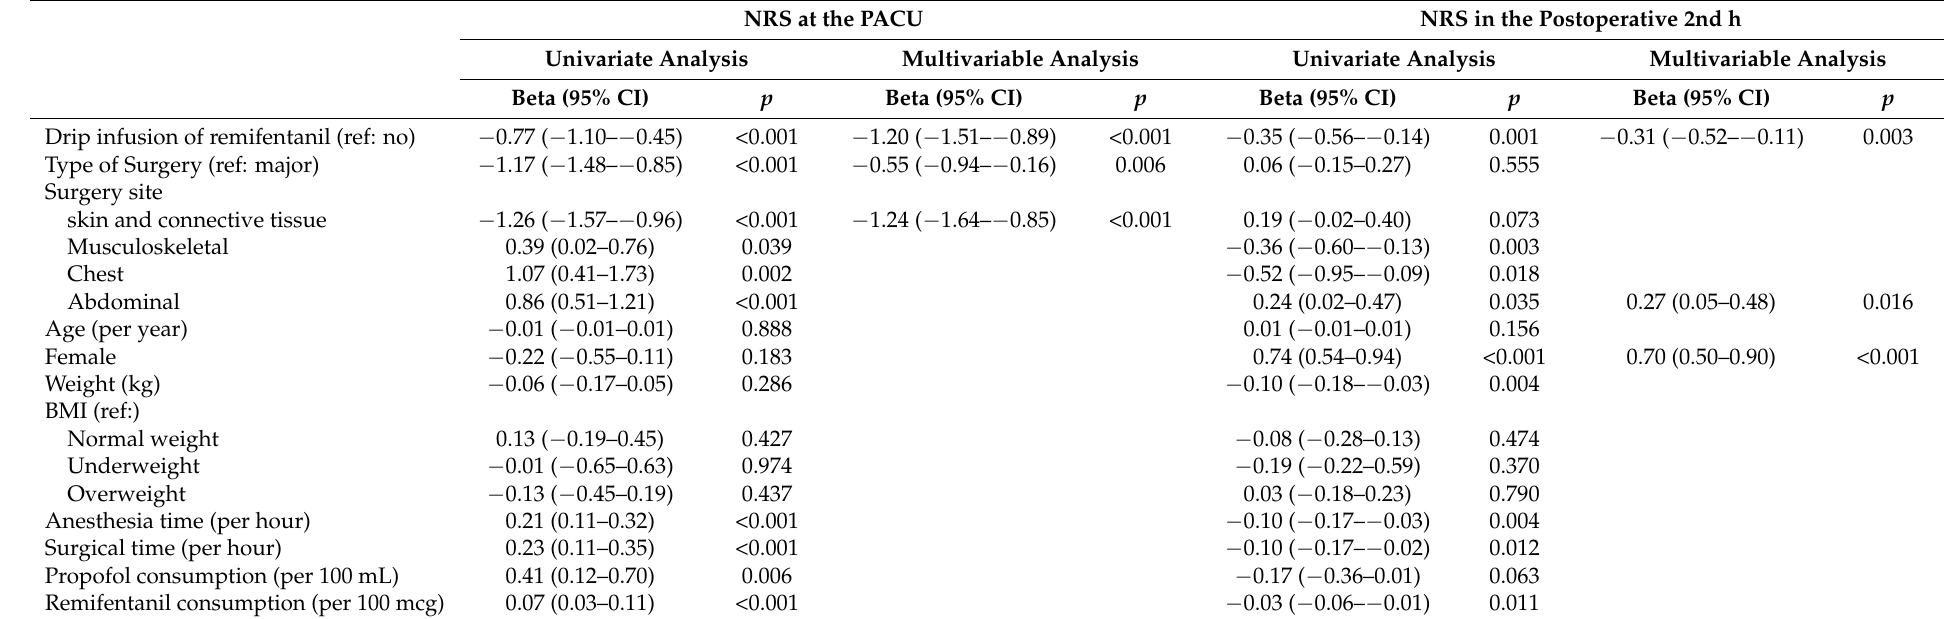
Table 3. Linear regression analysis demonstrating factors associated with elevated